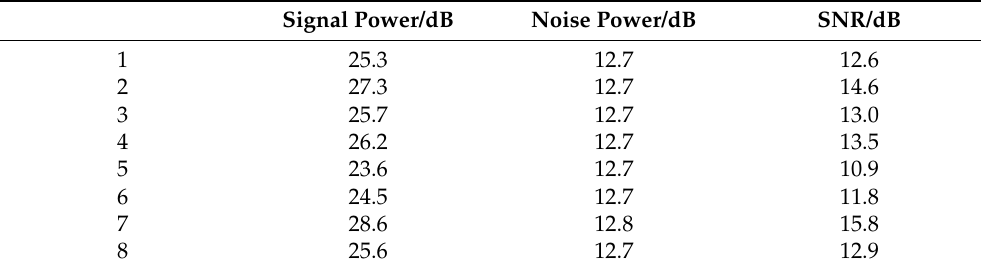
Figure 17. The echo diagram of 20 echo period signals with accumulated SNR of ( a ) 12.6 dB, ( b ) 14.6 dB, ( c ) 13.5 dB, and ( d ) 10.9 dB under the condition of 0 dB SNR. Table 3. The power values of 20 echo period signals under the condition of 0 dB SNR. Signal Power/dB Noise Signal Power/dB